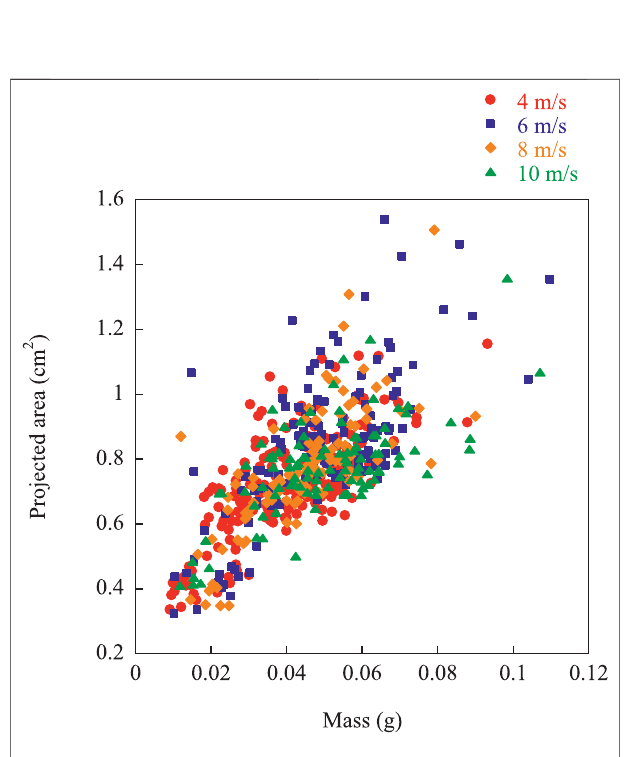
FIGURE 4 | Characteristics of fi rebrands under 4, 6, 8 and 10 m s − 1 .